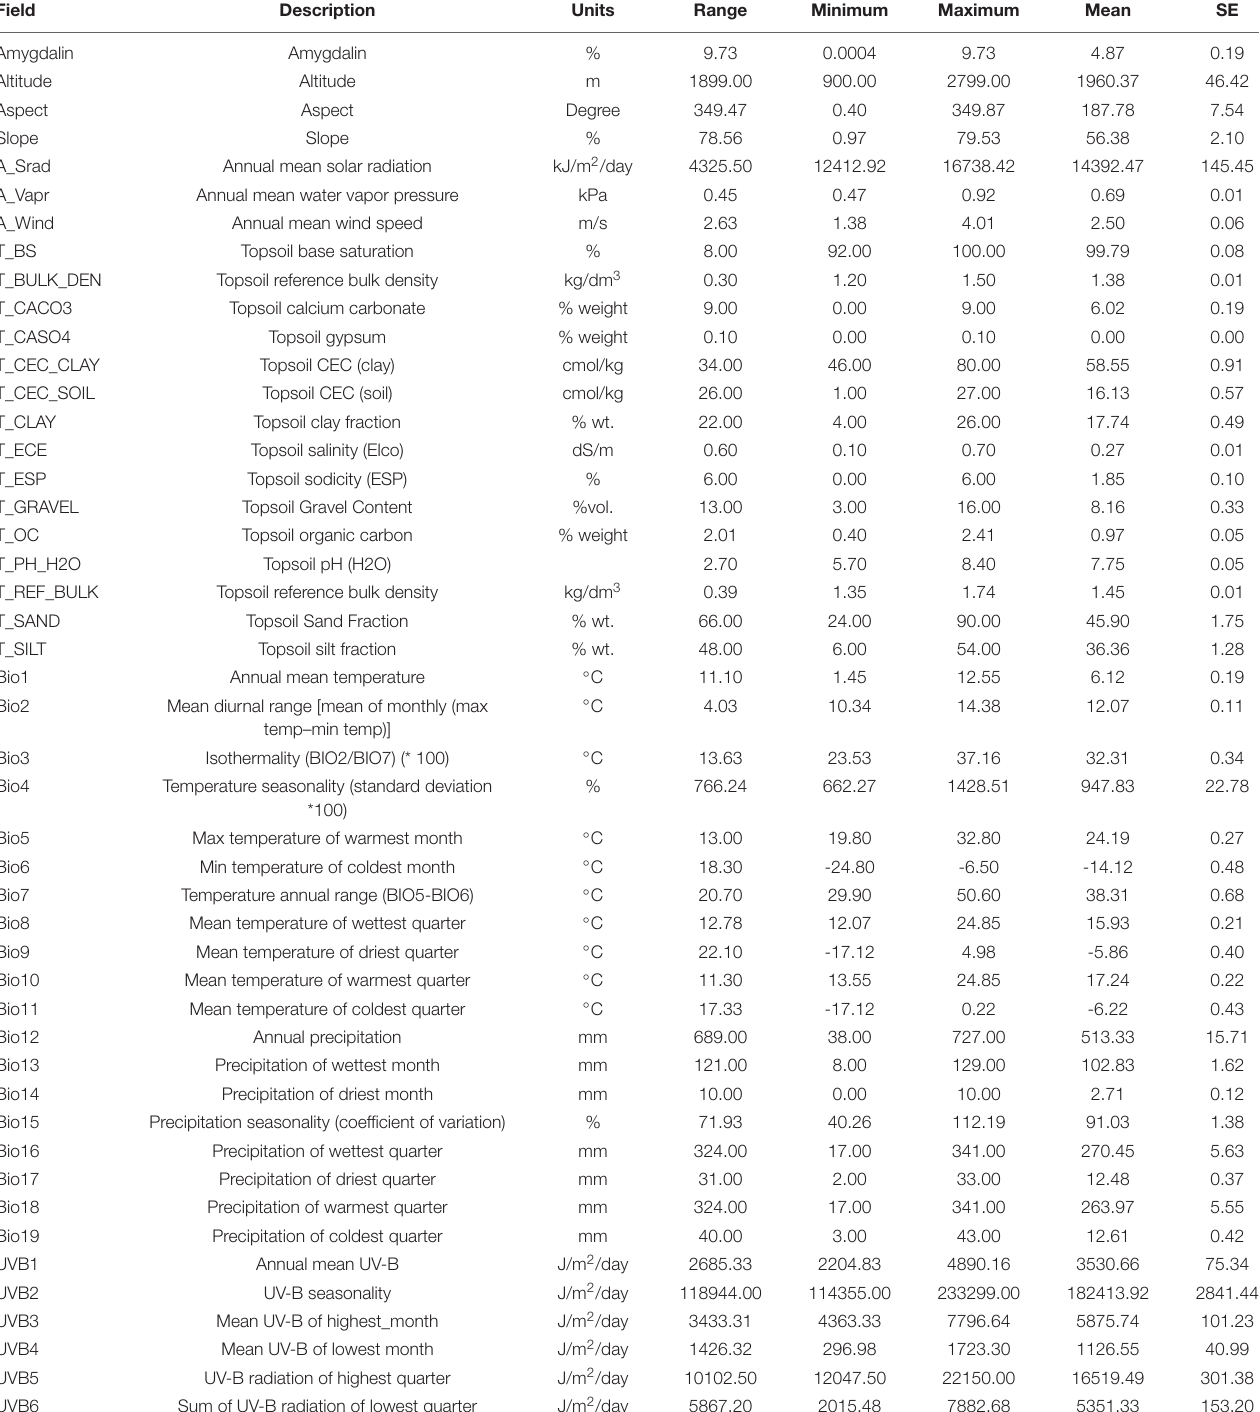
TABLE 1 | Statistical analysis of amygdalin and environmental